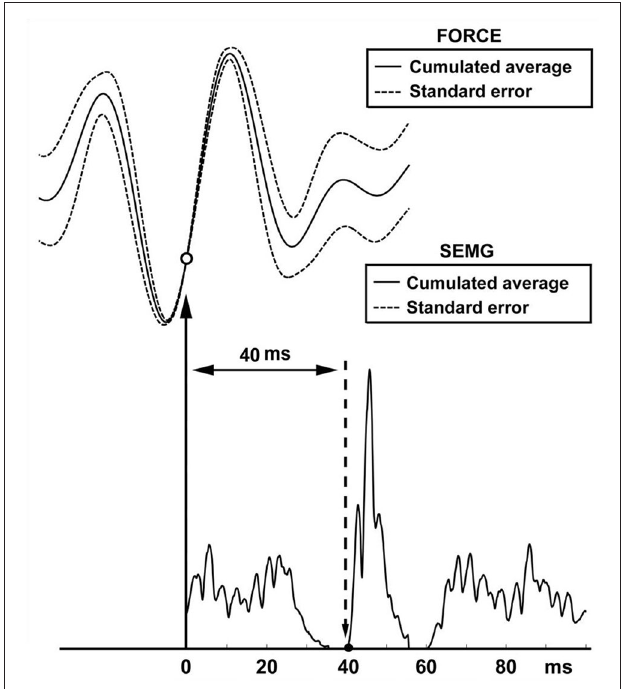
FIGURE 6 | Reflex latency measurement using cumulated average method in simulation data . Open circle shows the lowest value of the SE of force trace (effective stimulus point). Solid circle shows the lowest value of the SE of EMG trace (onset of EMG response).